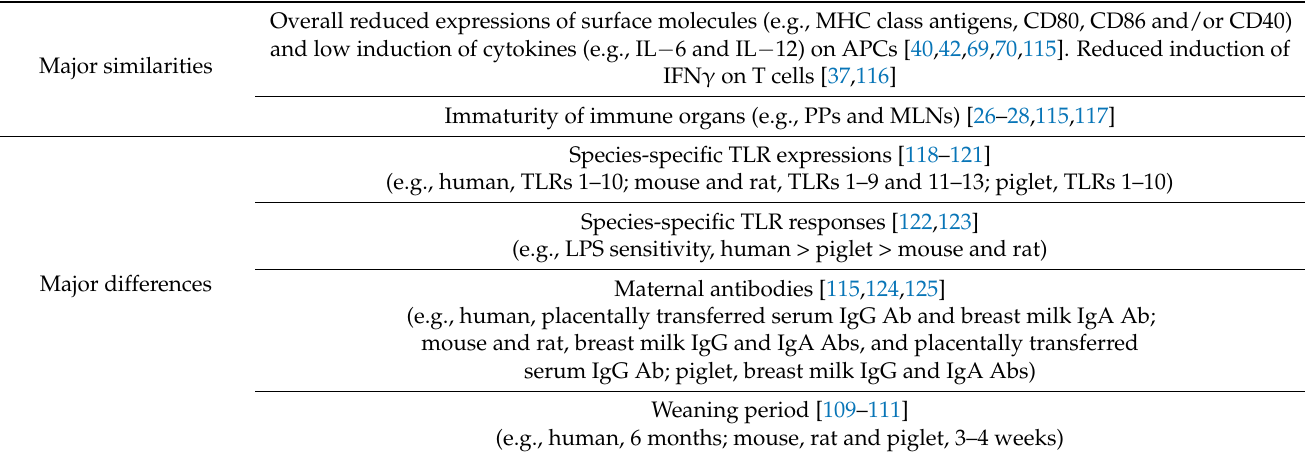
Table 1. Major similarities and differences among neonatal and infant animal models for the immunization research. Overall reduced expressions of surface molecules (e.g., MHC class antigens, CD80, CD86 and/or Major similarities